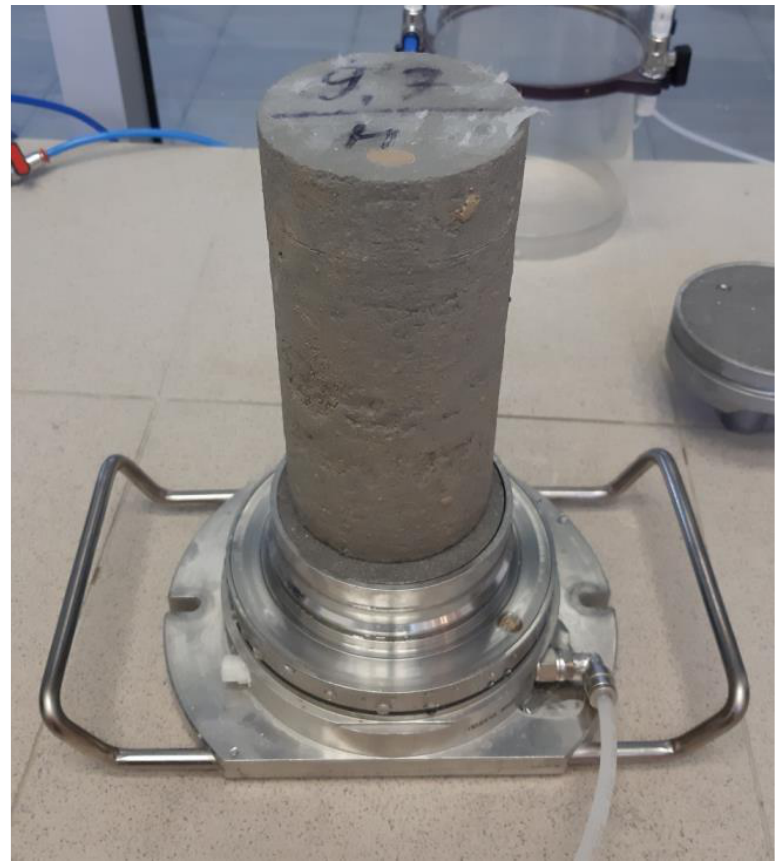
Figure 1. A fully water-saturated soil-cement specimen on the dismountable lower pedestal of the resonance column.